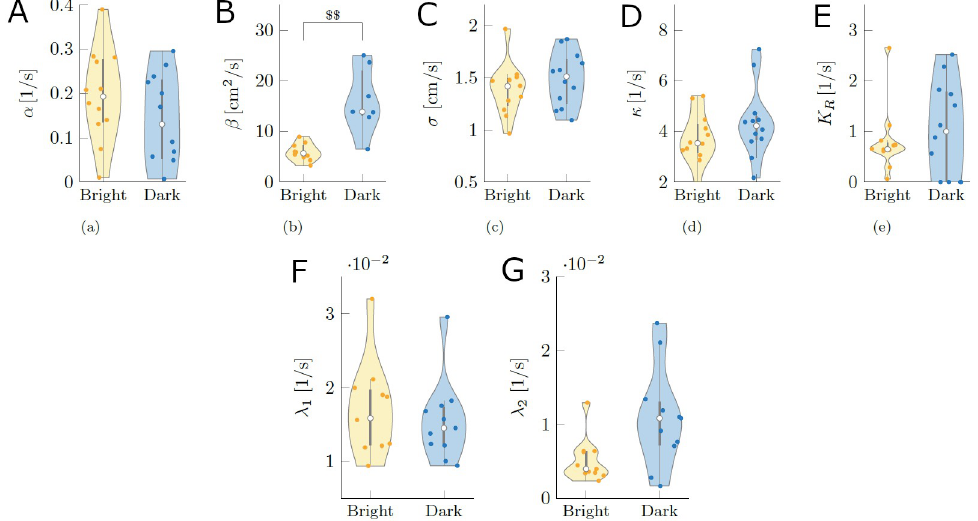
Fig 4. Calibrated model parameters for conditions Bright and Dark. (A) Linear rate of decay of the vortex strengths. (B) Baseline value of the vortex strengths. (C) Intensity of the noise added to the time-evolution of vortex strengths. (D) Coupling gain between vortex strengths associated with the ability of a fish to resume straight swimming after a maneuver. (E) Hydrodynamic feedback gain. (F-G) Rates of transitioning from dismissing to using information about the local circulation and vice versa. The gray bar in each violin plot details median (white dot), first and third quartiles, and lower and upper adjacent values. The colored area of a violin plot corresponds to the probability density of the data. Symbol $$ indicates a significant difference between conditions with p <